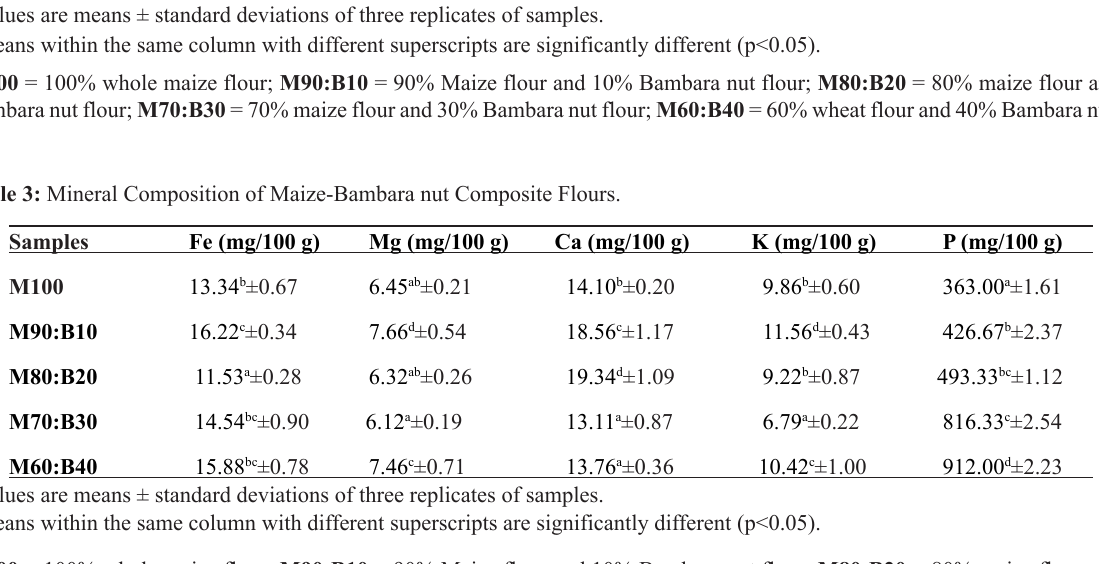
*Values are means ± standard deviations of three replicates of samples. *Means within the same column with different superscripts are significantly different (p<0.05).